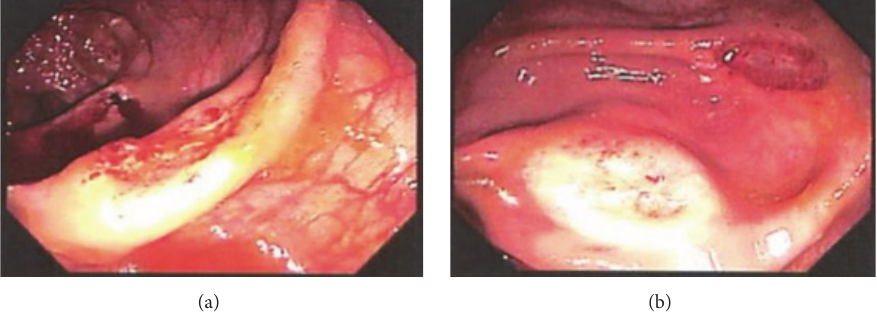
Figure 2: (a) Colonoscopy revealing several diffuse ulcerated focal lesions in the ascending colon and cecum. (b) Colonoscopy revealing several diffuse ulcerated focal lesions in the ascending colon and